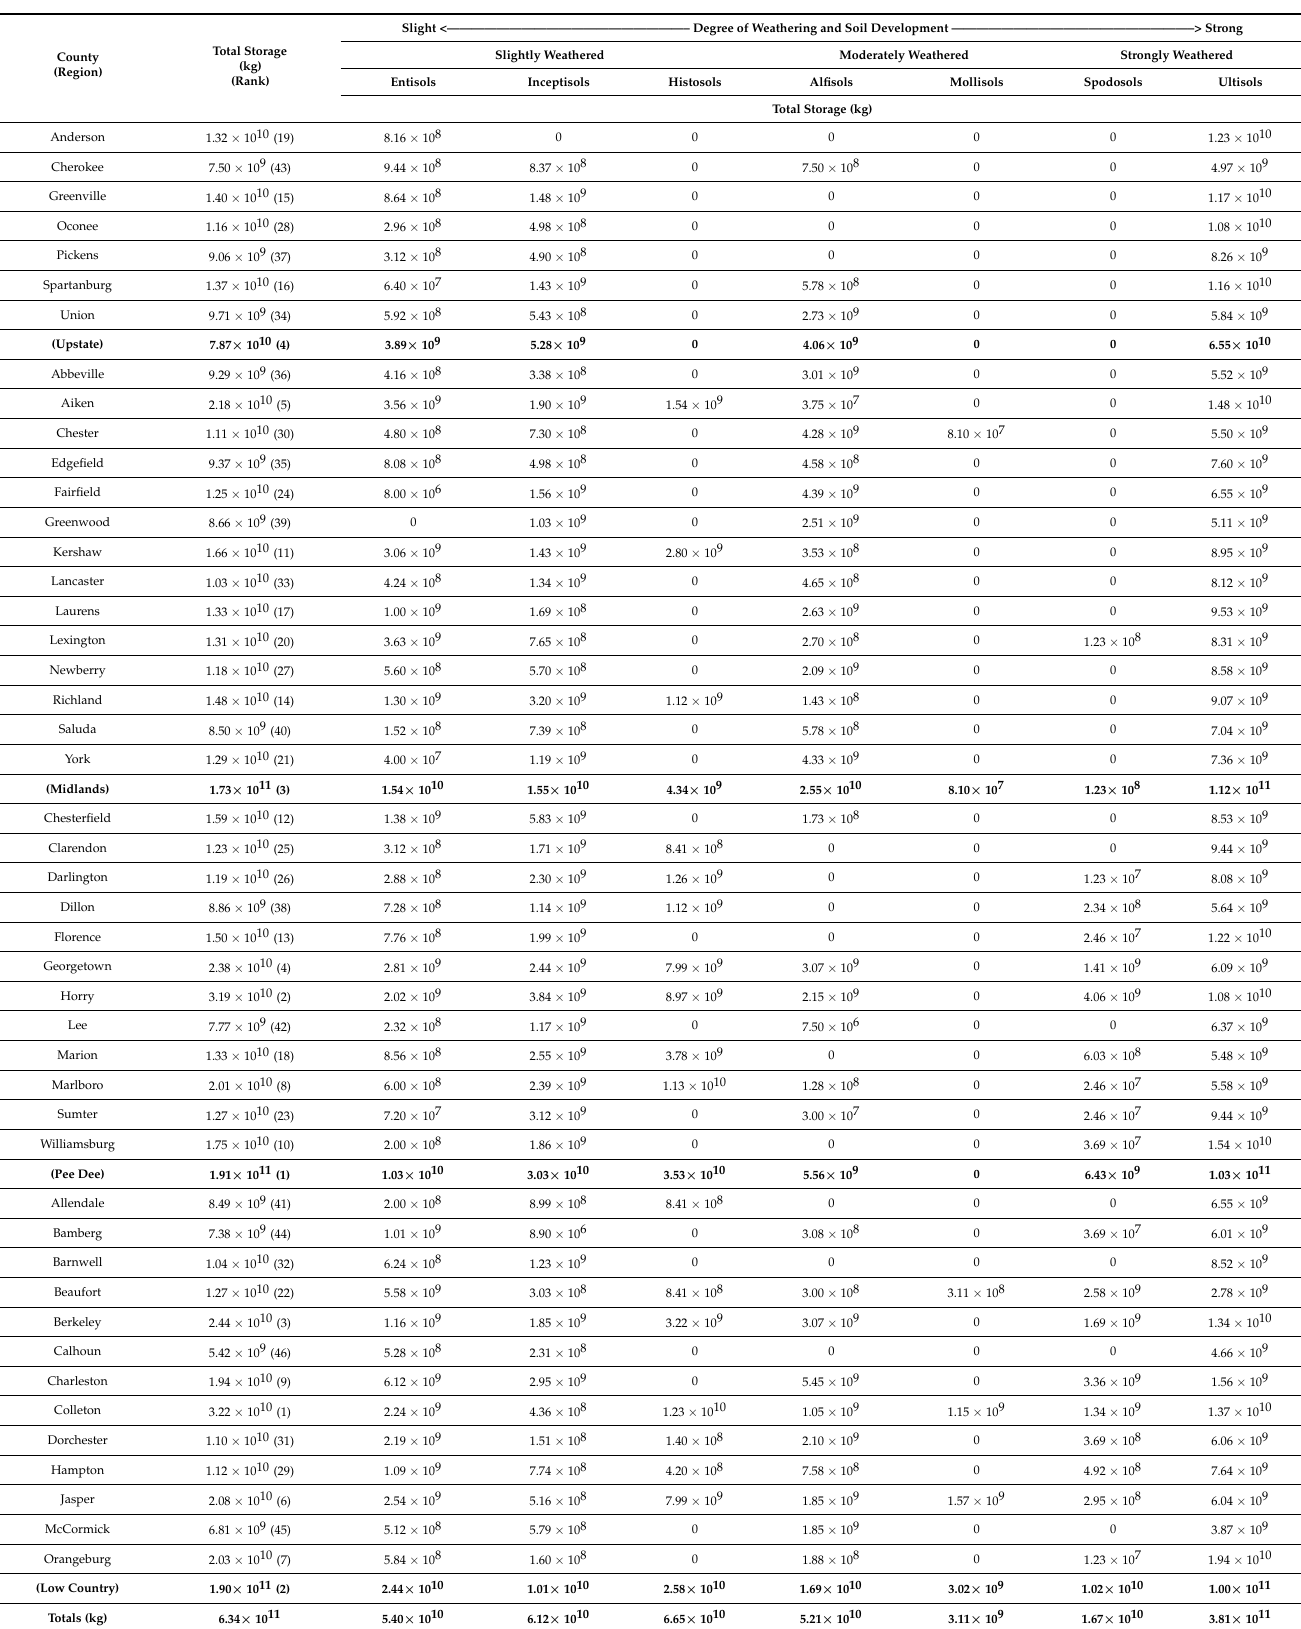
Table 5. Mid-point total soil organic carbon (SOC) storage values by county, region, and soil order for the state of South Carolina (U.S.A.), based on mid-point soil organic carbon (SOC) content numbers in the upper 2 m of the soil based on data from Guo et al., 2006